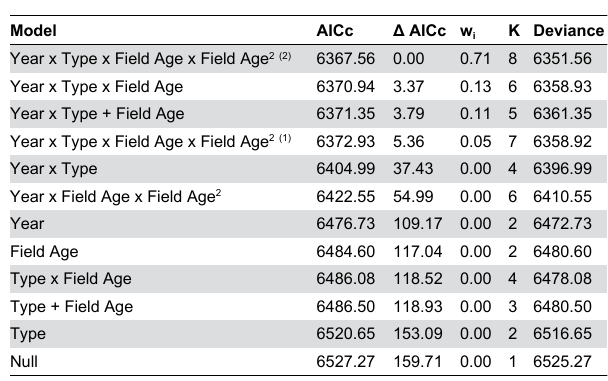
Table 5. Model selection results based on Akaike’s Information Criterion (AIC), including number of parameters (K) and model weight (w ), used to examine the effect of i cover type, year, and age of field on nest success in multi- species native plantings and dense nesting cover in 2010-11 in Devils Lake Wetland Management District, North Dakota.